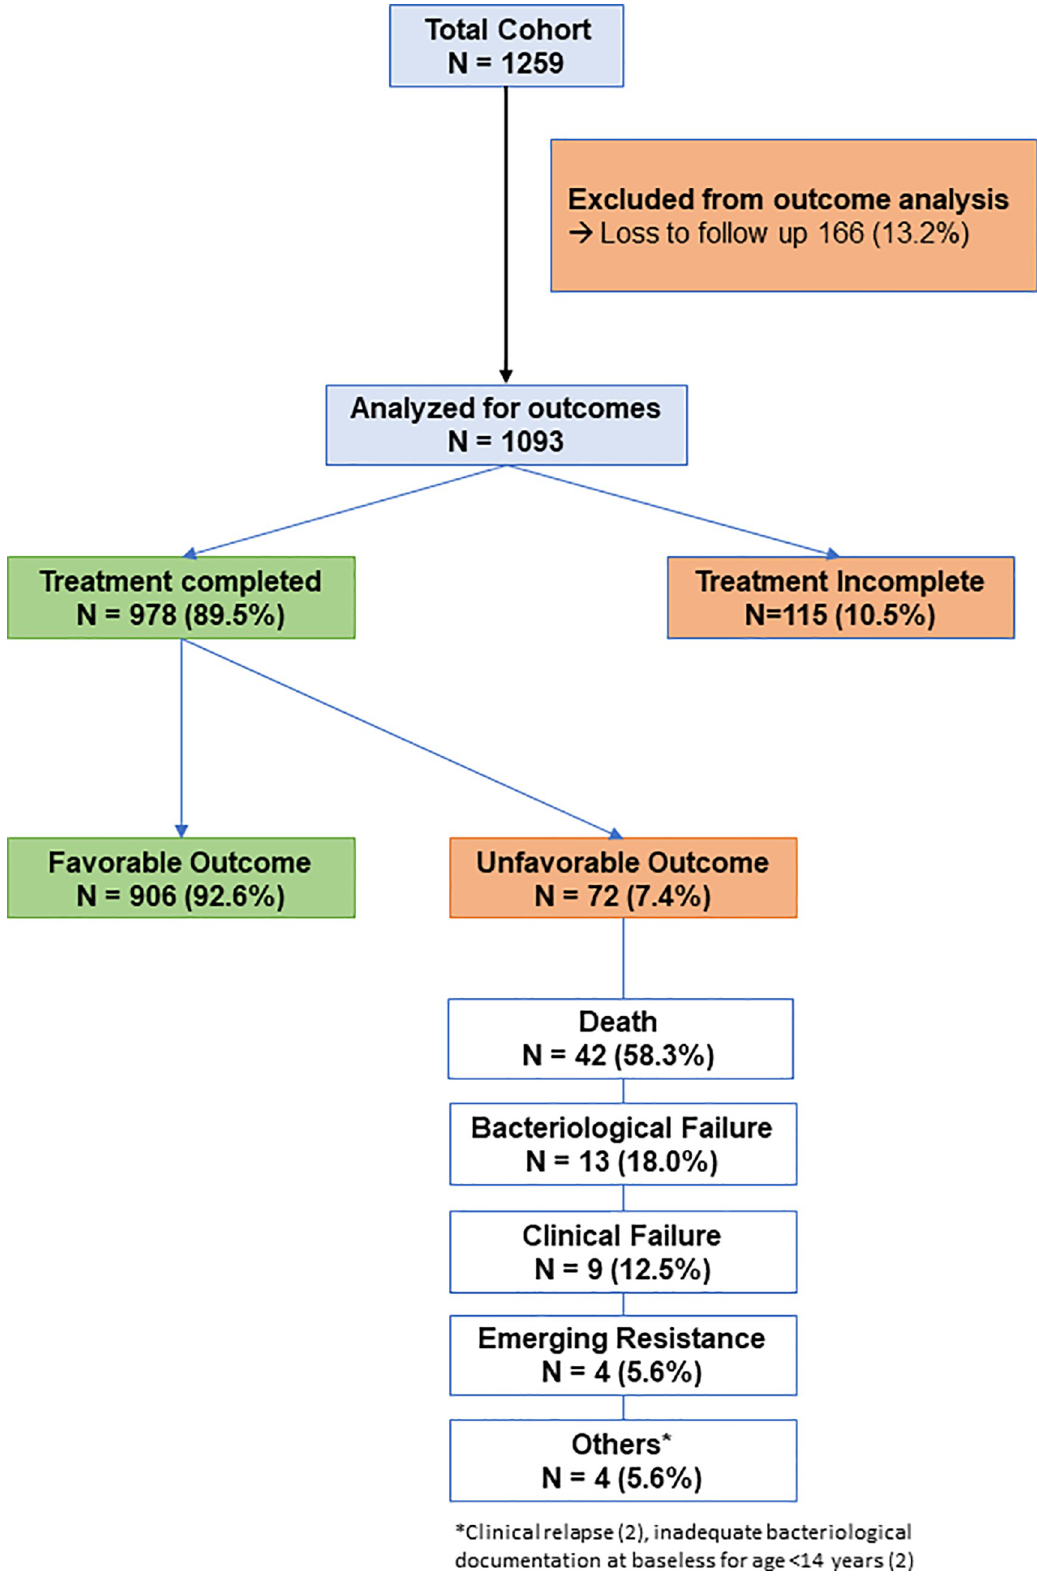
Fig 1. Summary of flow of participants into various stages during the follow up of the study. https://doi.org/10.1371/journal.pone.0256773.g001 PLOS ONE | https://doi.org/10.1371/journal.pone.0256773 August 27,